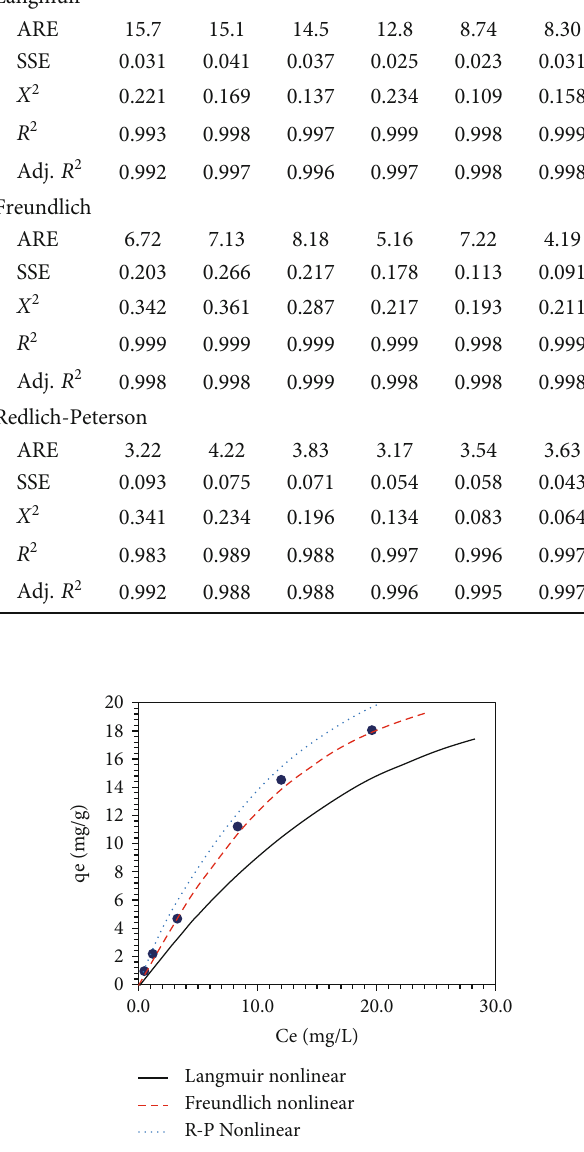
Figure 7: Adsorption isotherm for Pb (II) on MBS ( T = 35 ° C, m = 10 g/L).